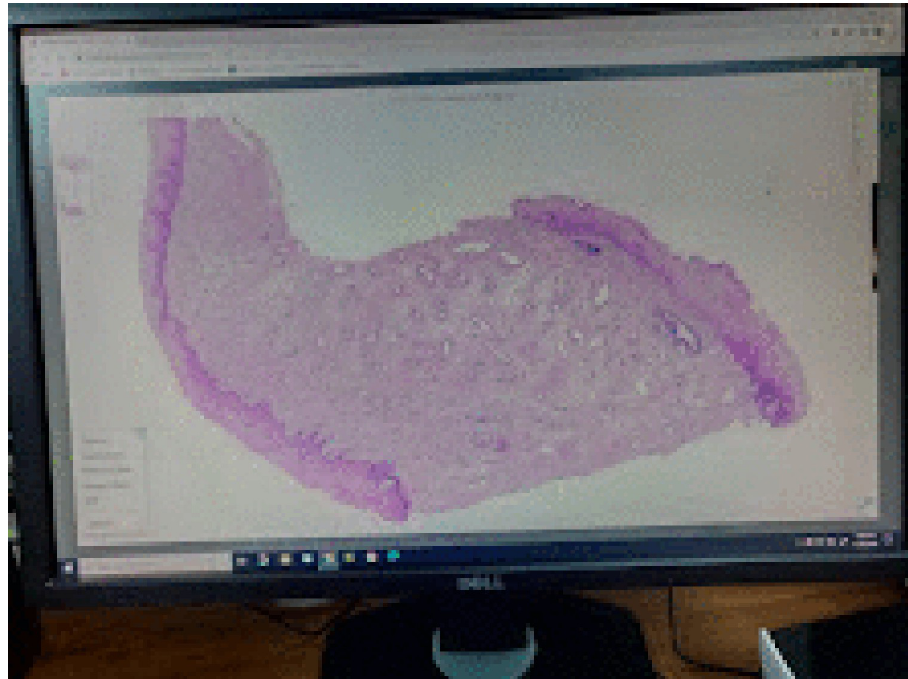
Fig 2. Telepathology working station portal illustrating the digital image of a normal cervical biopsy, H&E staining 20 x original magnification.